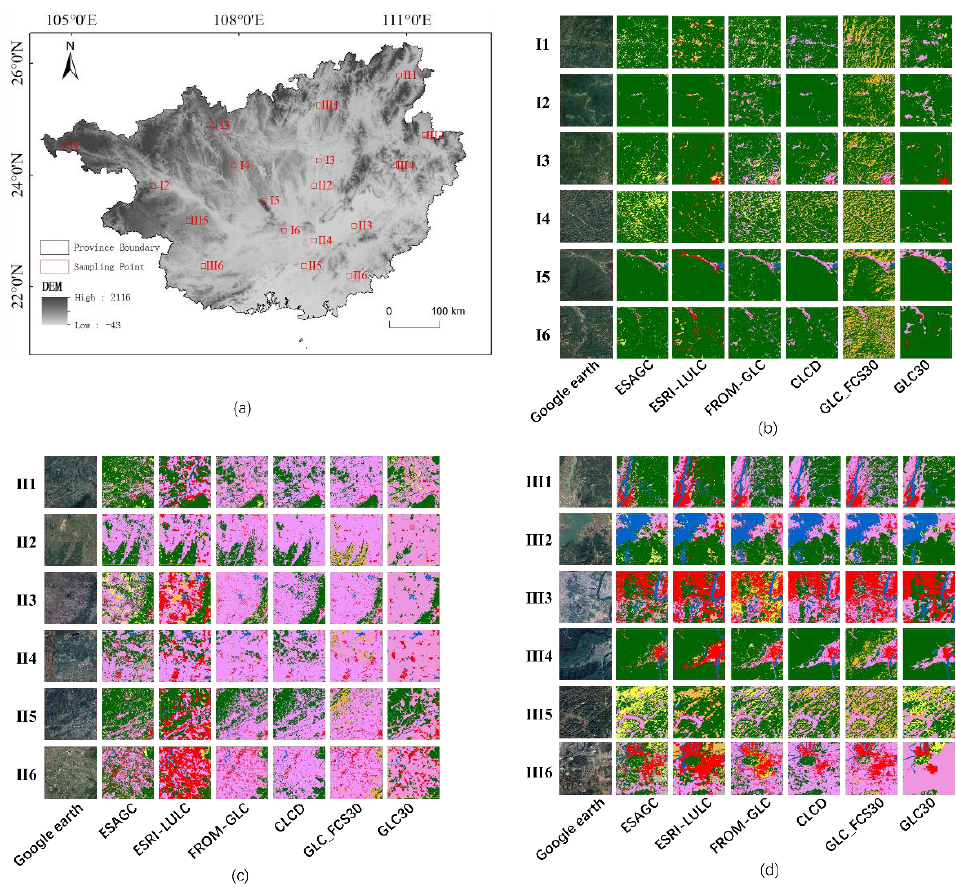
Figure 10. Partial comparison of the six land cover products with Google Earth imagery: ( a ) locations of sample areas used for the comparison together with a digital elevation map for Guangxi, ( b ) details of the comparison for sample areas with large differences in forest area at the municipal level, ( c ) details of the comparison for sample areas with large differences in cropland area at the county level and ( d ) details of the comparison for sample areas with complex land cover types.